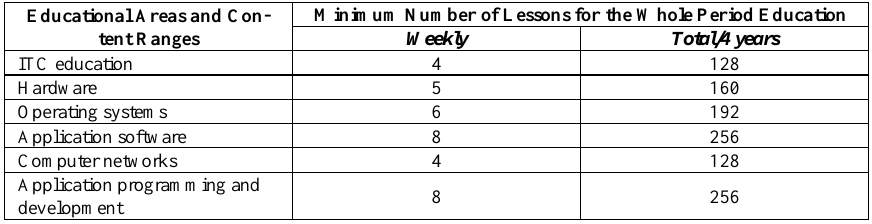
Table 2. Framework